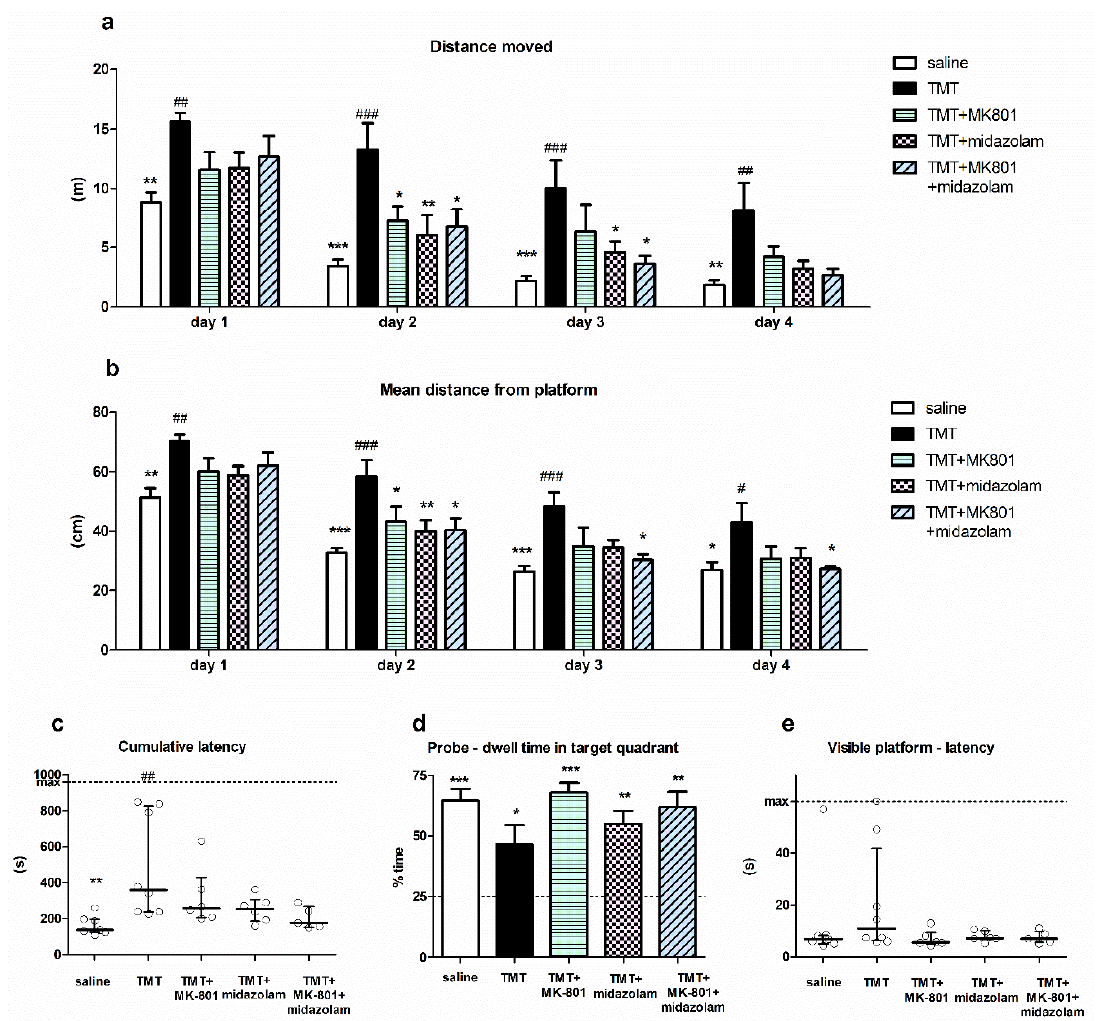
Figure 3. Morris water maze. ( a ) Distance moved. Group mean + SEM, two-way repeated measures ANOVA and Bonferroni post hoc test (treatment effect within day), * p < 0.05, ** p < 0.01, *** p < 0.001 vs. TMT, ## p < 0.01, ### p < 0.001 vs. saline. ( b ) Mean distance from platform. Group mean + SEM, two-way repeated measures ANOVA and Bonferroni post hoc test (treatment effect within day), * p < 0.05, ** p < 0.01, *** p < 0.001 vs. TMT, # p < 0.05, ## p < 0.01, ### p < 0.001 vs. saline. ( c ) Cumulative latency. Kruskal – Wallis with Dunn’s multiple comparison test, ** p < 0.01 vs. TMT, ## p < 0.01 vs. saline. Median with interquartile range, circles represent values from individual animals. ( d ) Probe trial — dwell time in target quadrant. Group mean + SEM, asterisks denote difference from the quadrant choice equivalent to random chance (25%, indicated by the dashed line) analyzed using one-sample t -test, * p < 0.05, ** p < 0.01, *** p < 0.001. ( e ) Visible platform trial — latency to find the platform. Median with interquartile range, circles represent values from individual animals.